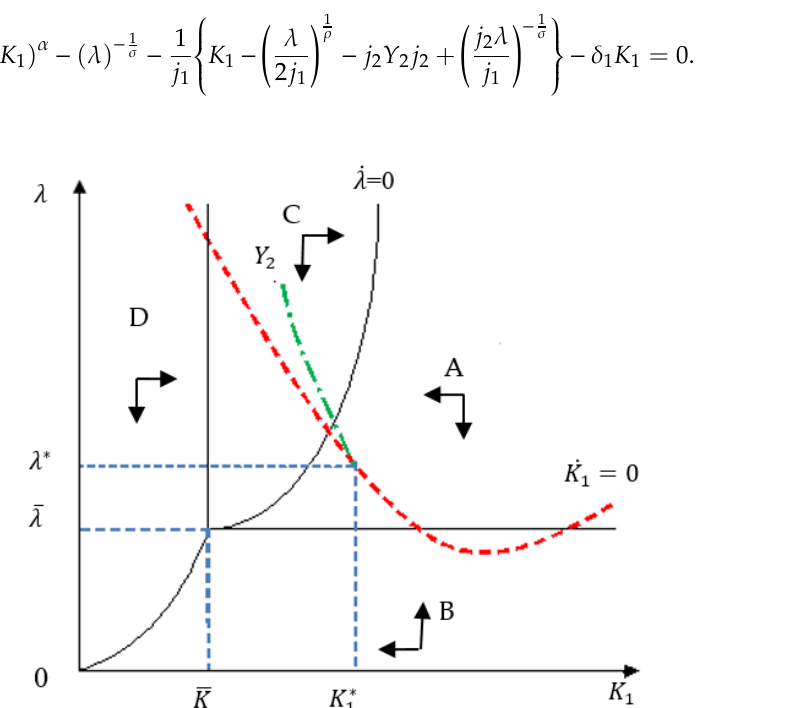
Figure 2. The phase diagram on the optimal economic growth path for the developing country. In Figure 2, four boundaries intersect at the point (𝐾̅, 𝜆̅) . Here, 𝐾̅ = ((𝑌 2 ) −𝜎 2𝑗 2 ⁄ )